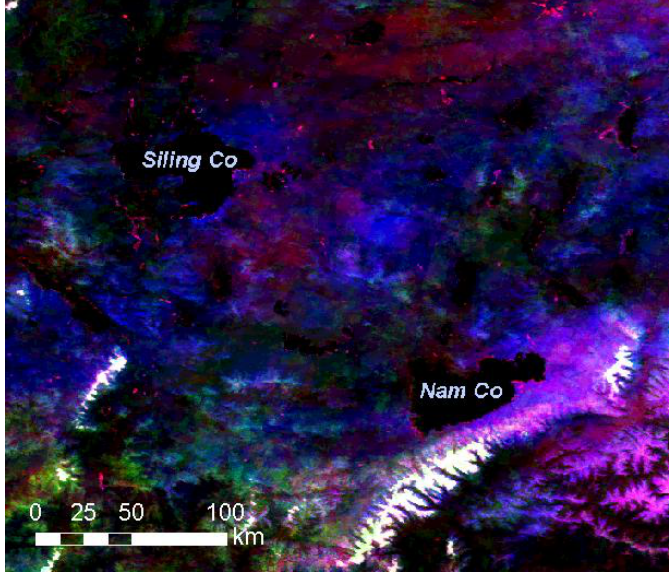
Figure 7. RSD image from MODIS Terra (year 2004) covering both Siling Co (upper left corner) and Nam Co. SE part of Nam Co Basin features strong lake effect in comparison to Siling